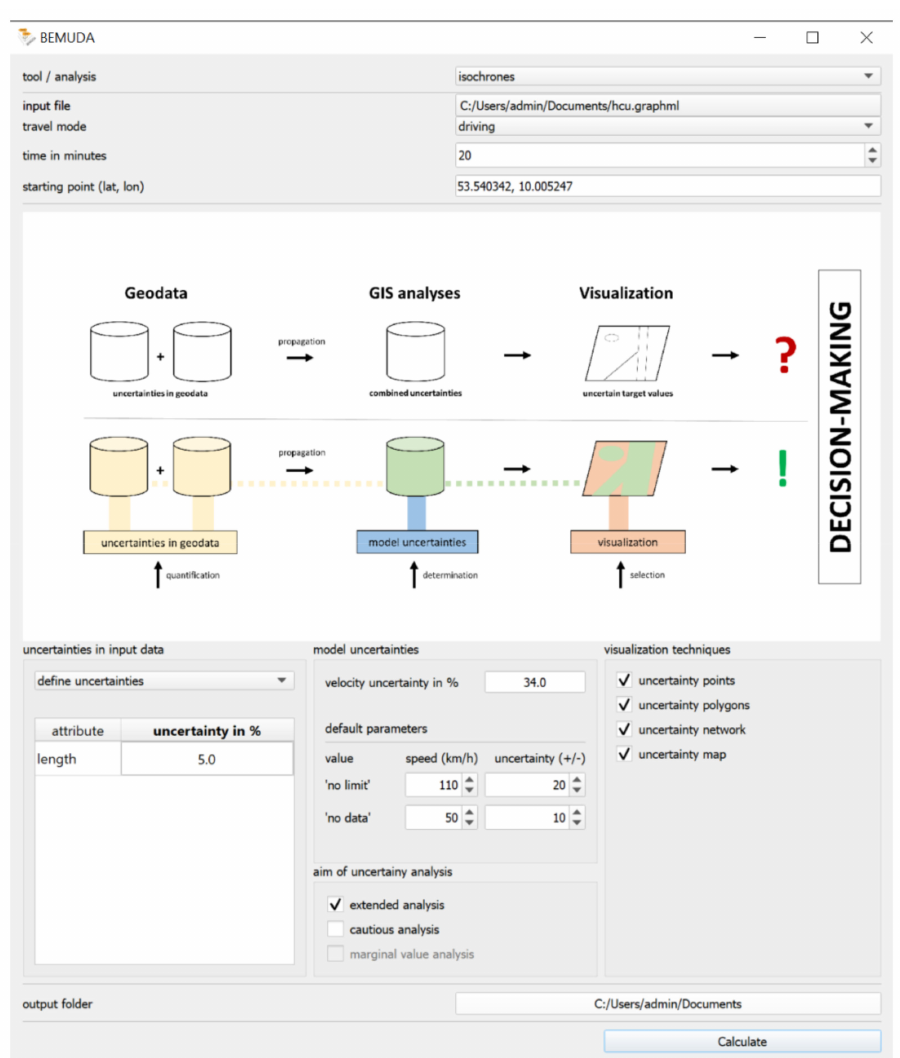
Figure 4. Graphical User Interface of the BEMUDA tool with common isochrone parameter input on the upper part of the interface and uncertainty quantification of input data ( left ), model parameters ( center ) and visualization techniques ( right ) on the lower